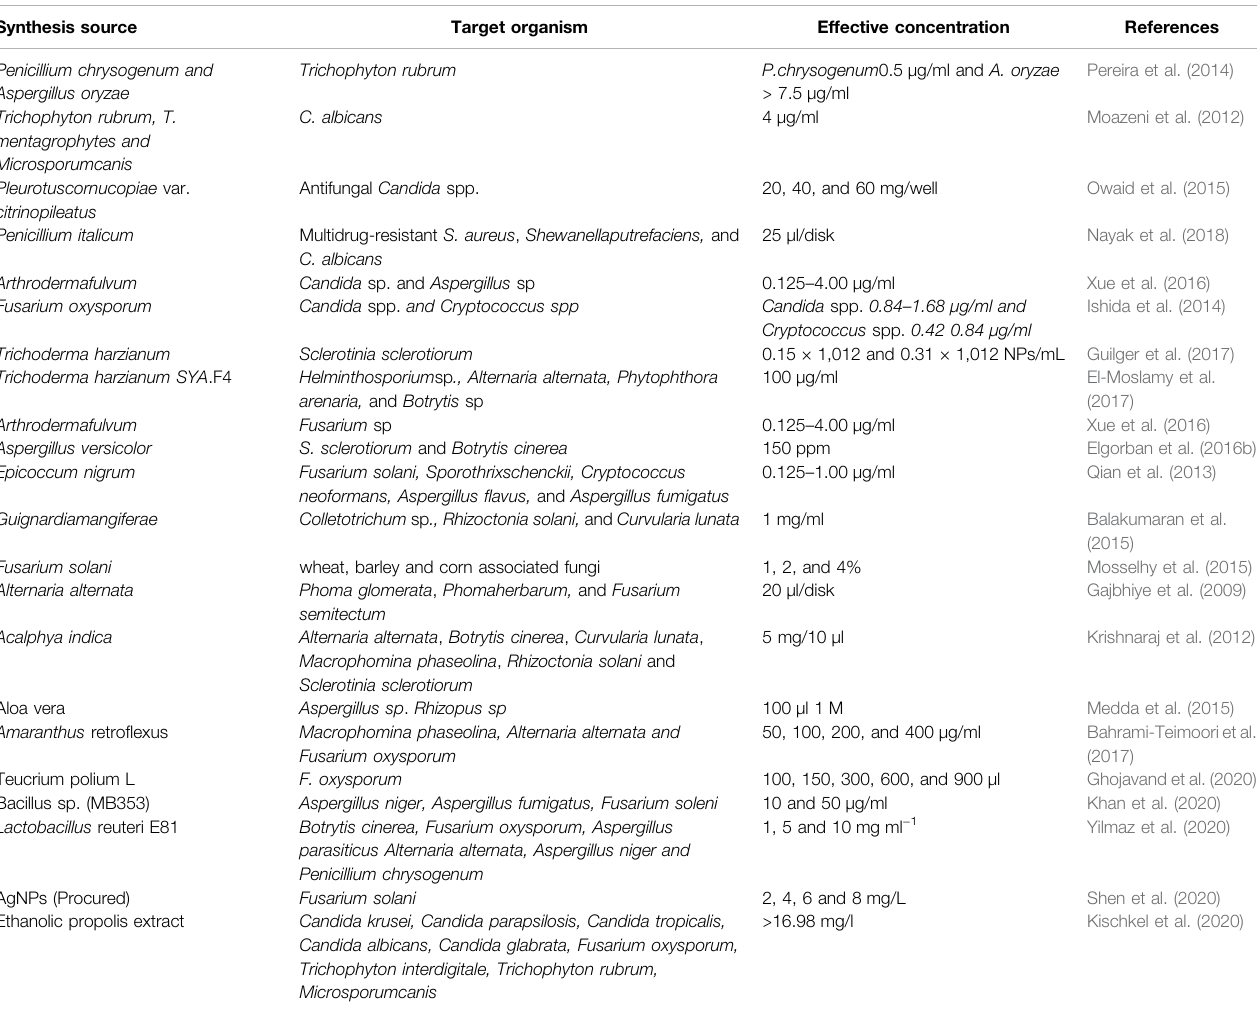
TABLE 1 | AgNPs formulations with effective concentrations against fungi using different